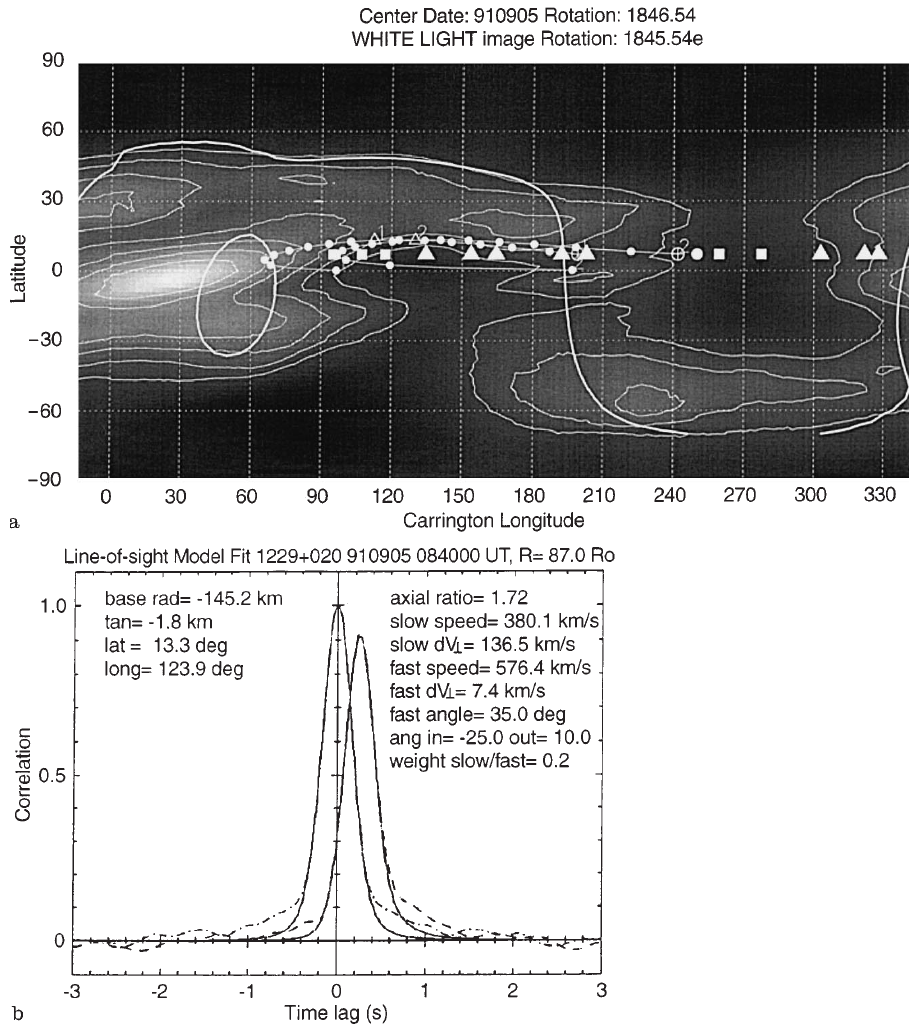
by IPS rotated past the Earth. b EISCAT correlation functions for the observation shown in a. The observed correlation functions are shown as broken lines and the results of the model fit as solid lines . The ‘‘fast’’ component is slower and produces more scintillation than would a normal stream, suggesting that a compression region moving at an intermediate velocity is present in